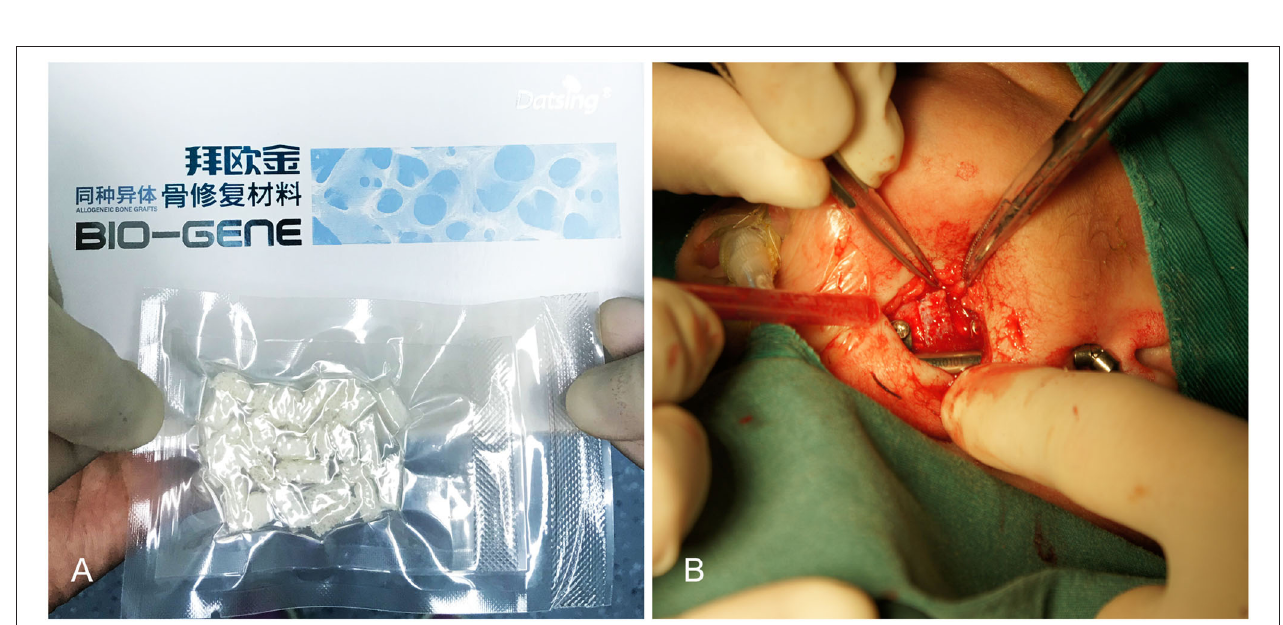
FIGURE 2 | (A) Filling this gap with 0.5mm allogenic acellular bone. (B) Making the two-side mandibular decellularized bone block clamping.